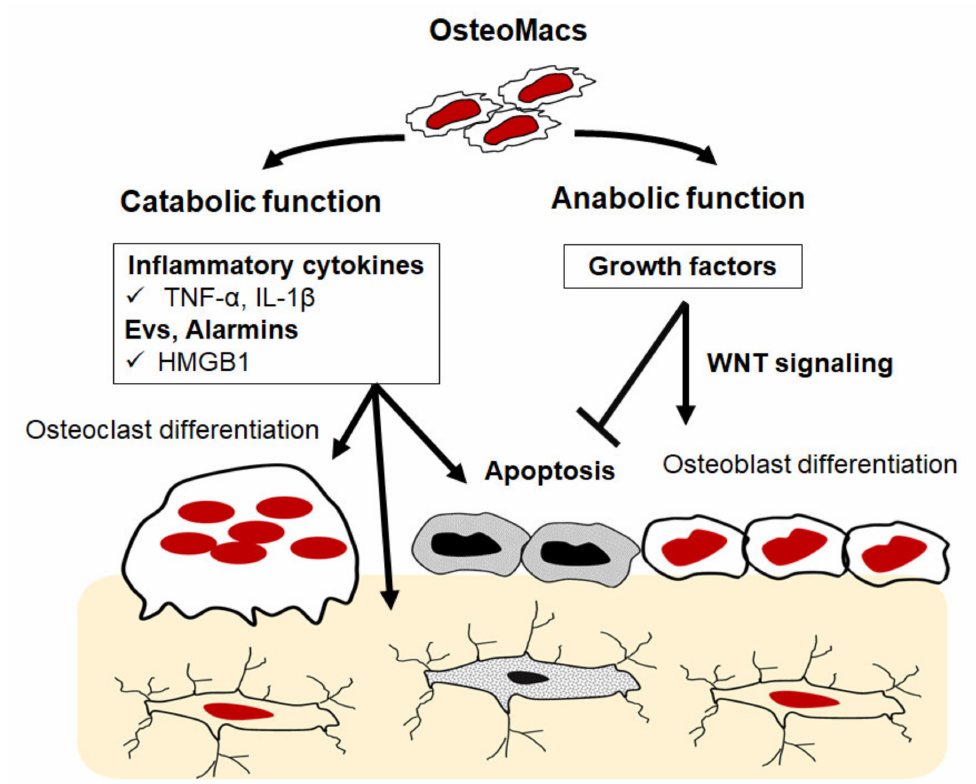
Figure 3. Schematic illustration of potential role of osteomacs in bone remodeling. Osteomacs can potentially produce inflammatory factors that promote osteoclastogenesis and apoptosis of osteoblasts and osteocytes. They are also able to produce anti-inflammatory and growth factors that positively regulate the function of osteoblasts and